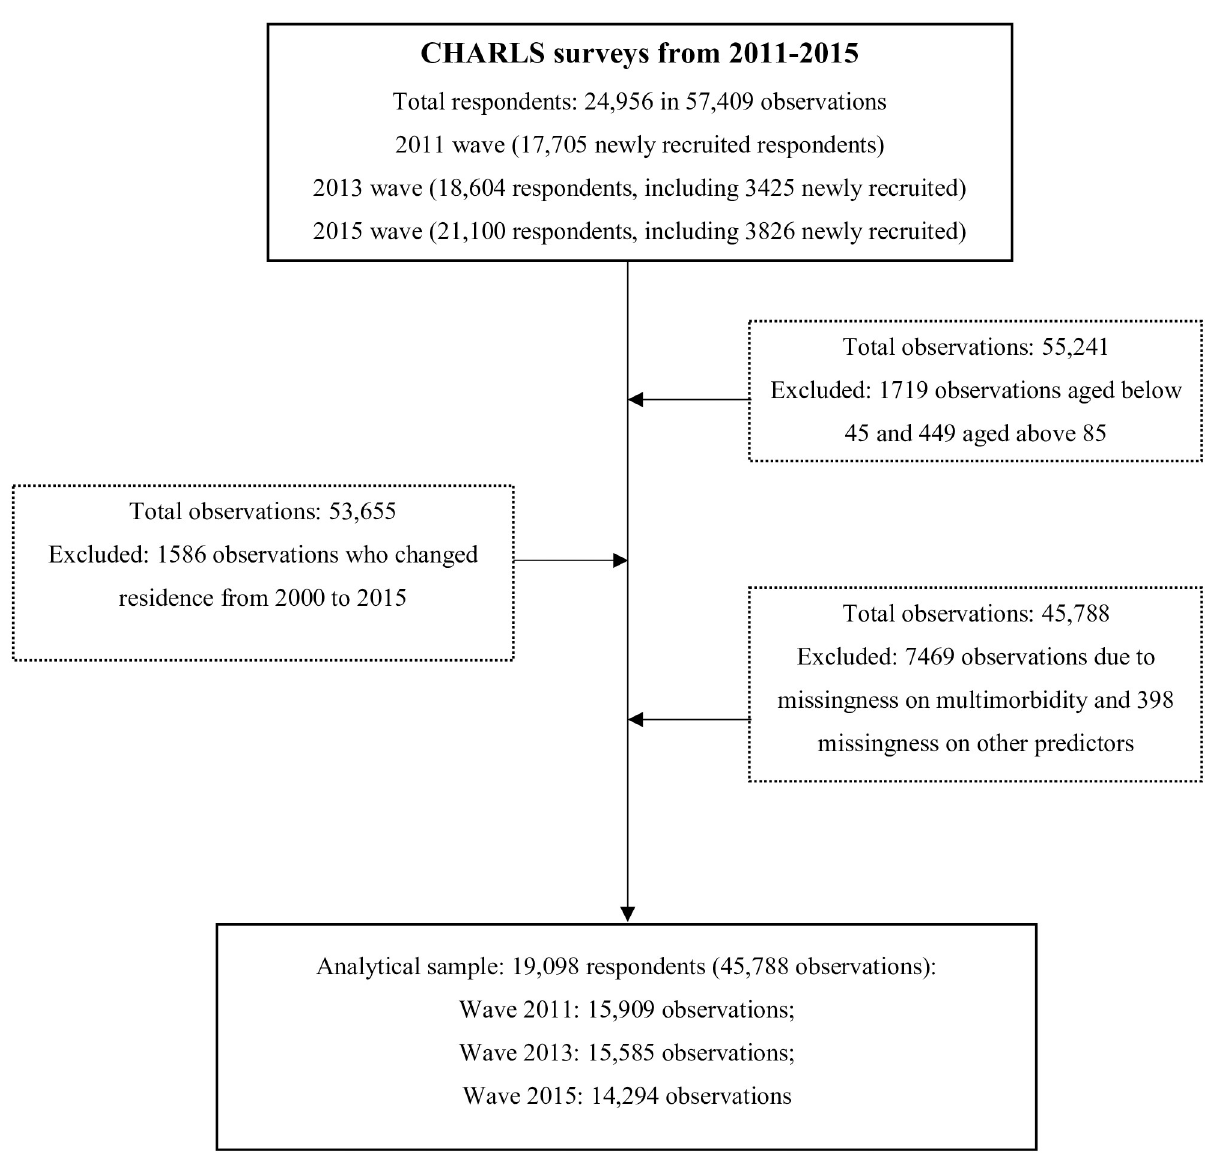
Fig 1. Flowchart of study inclusion criteria. Note: CHARLS, the China Health and Retirement Longitudinal Study.